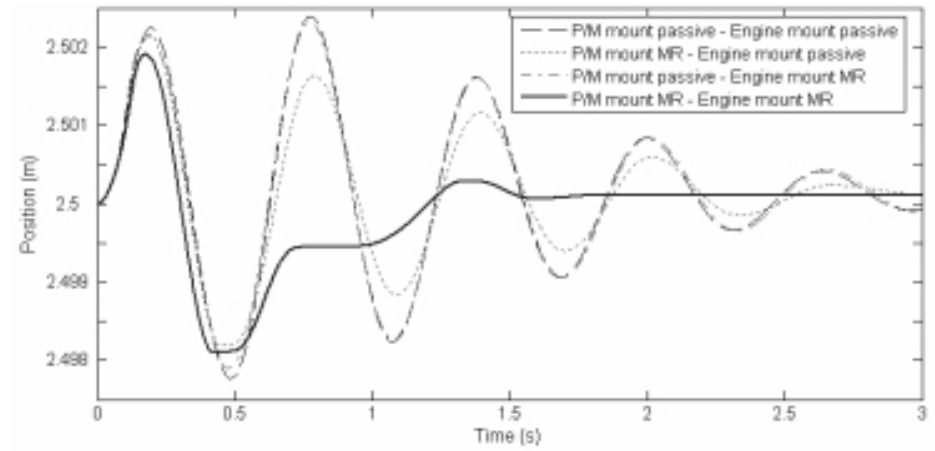
Fig. 7. Position of the chassis in time domain.